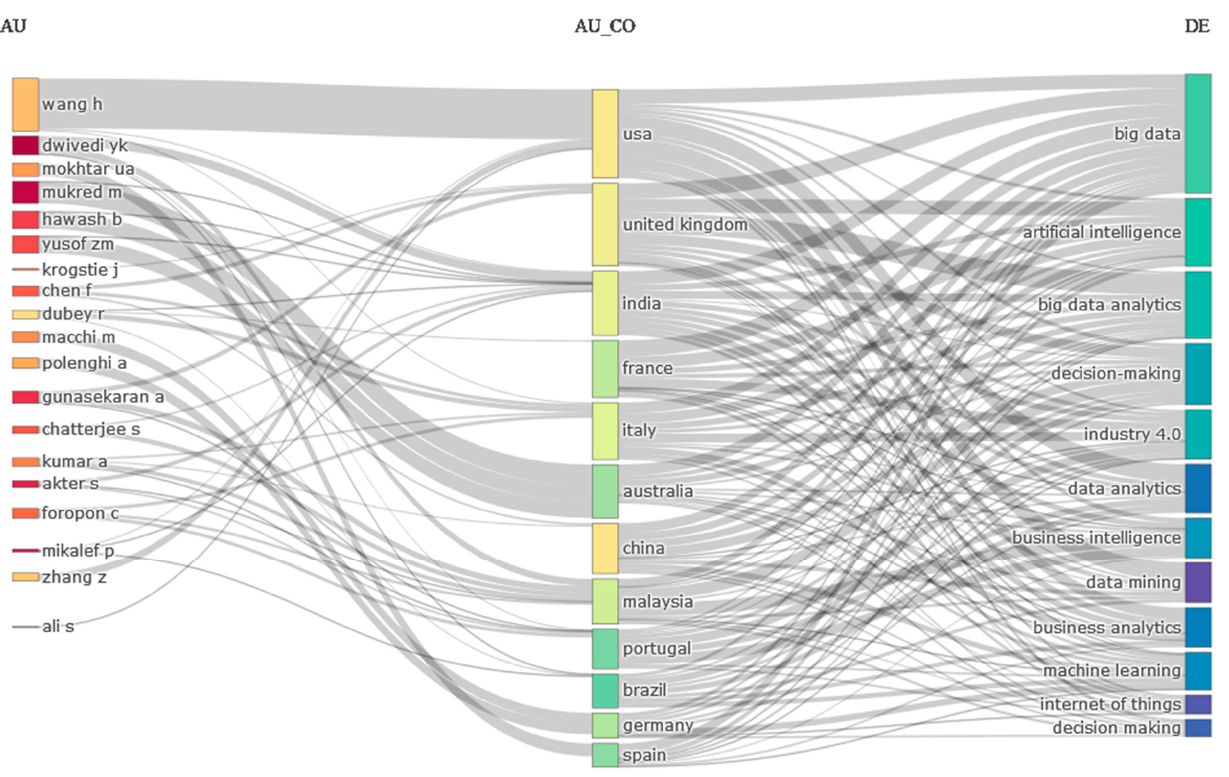
Figure 6. Three-Fields Plot.